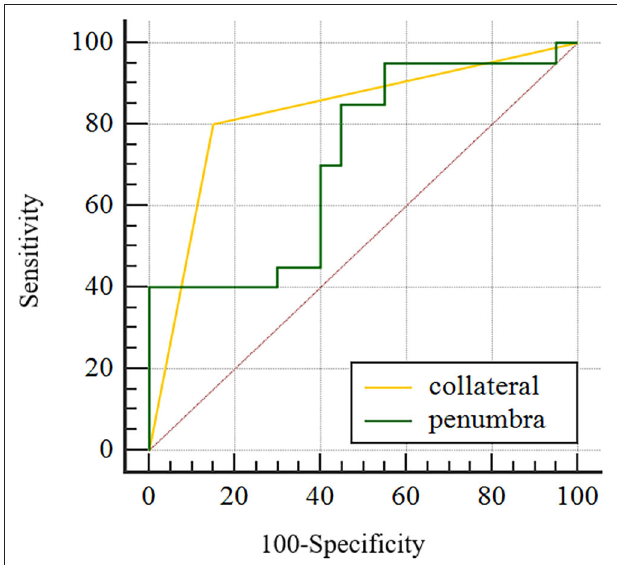
FIGURE 3 | Area under the curve for good collateral and penumbra volume in predicting functional independence (mRS 0–2) for WUS with large vessel occlusion in the anterior cerebral